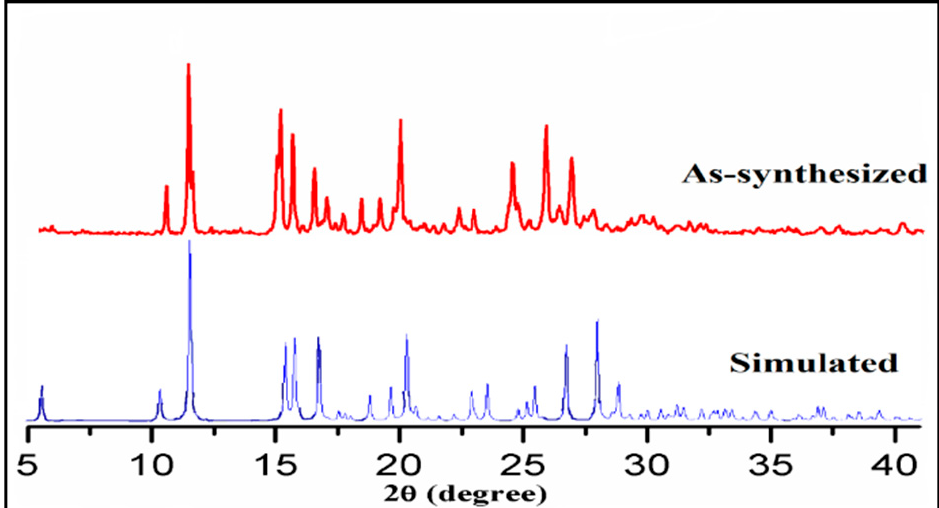
Figure 6. PXRD patterns of simulated (Blue) and synthesized (red) from complex 1 .